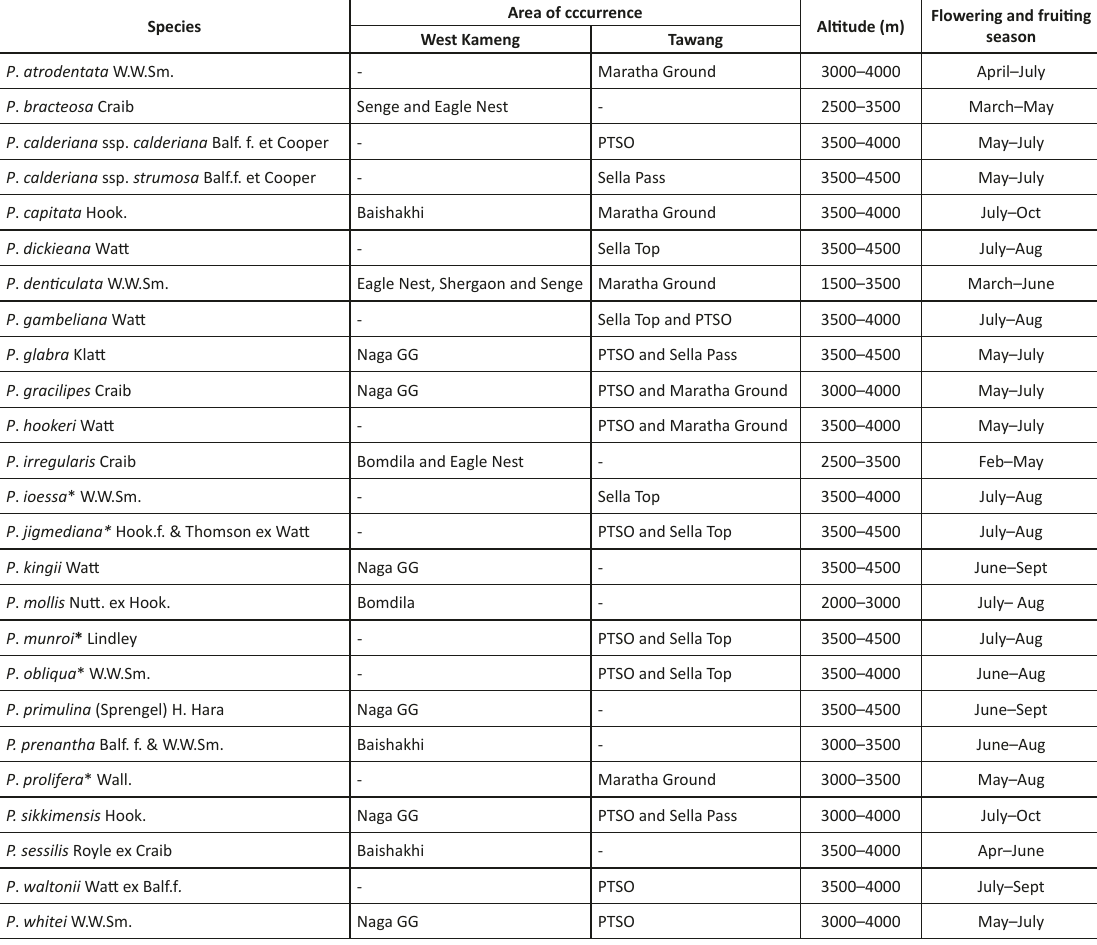
Area of cccurrence